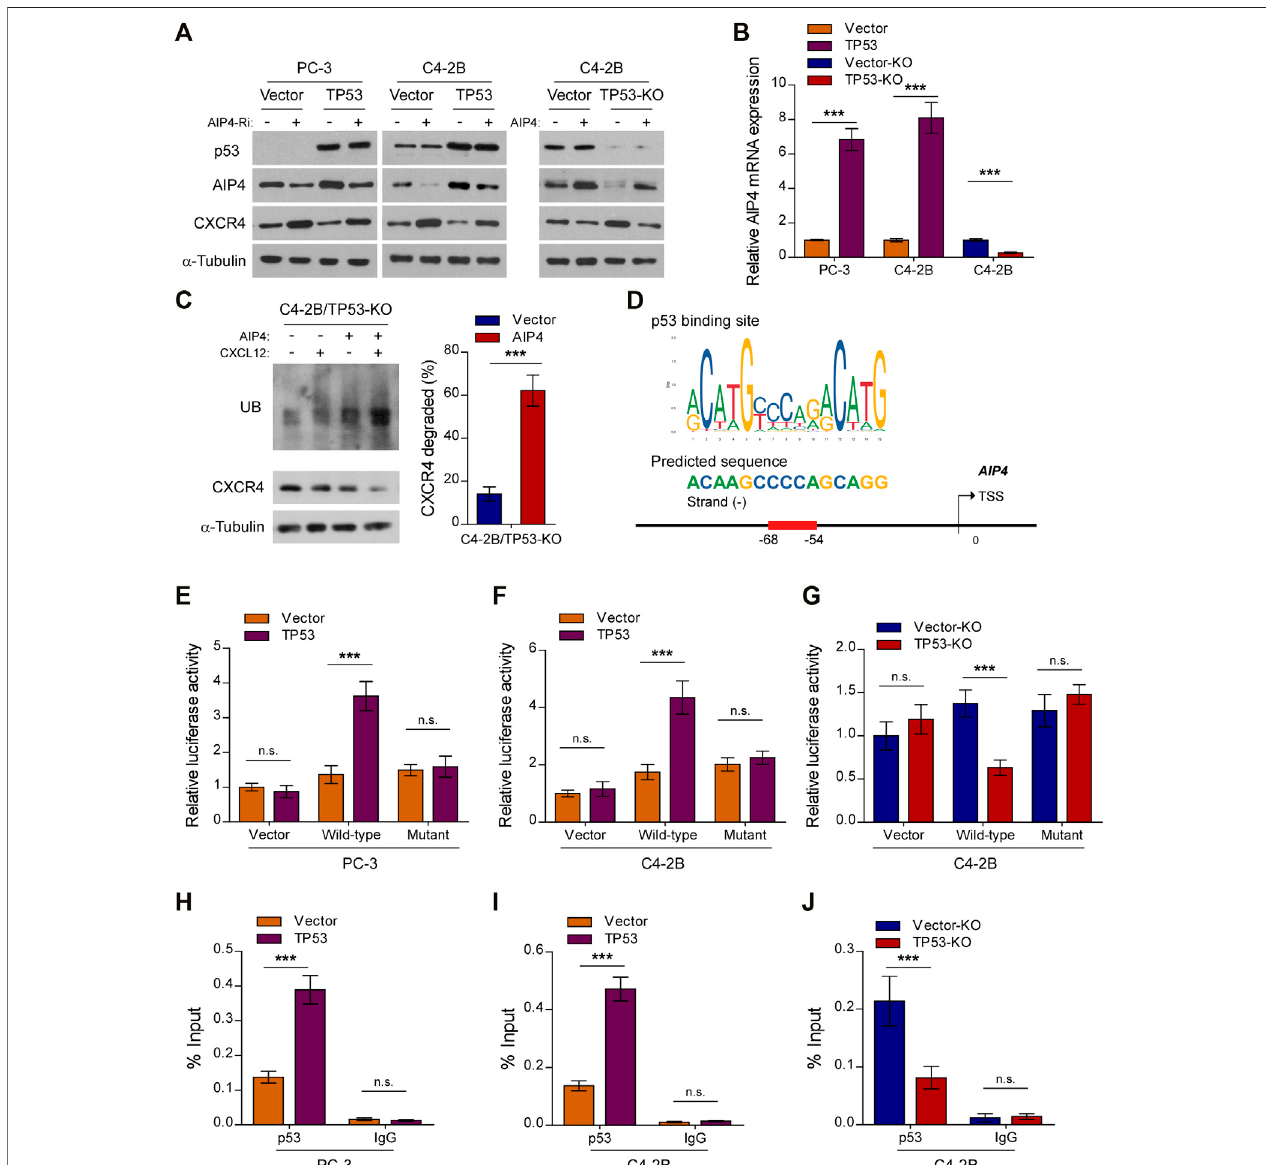
FIGURE 4 | Wt-p53 transcriptionally upregulates AIP4, a negatively regulator of CXCL12/CXCR4 signaling. (A) Western blot analysis of CXCR4 and AIP4 expressionintheindicatedcells. α -Tubulinservedasaloadingcontrol. (B) Real-timePCRanalysisof AIP4 mRNAexpressionintheindicatedcells.Transcriptlevelswere normalized to GAPDH. (C) Ubiquitination of CXCR4 was detected by Western blot. C4-2B/ TP53 -KO cells transfected with HA-tagged CXCR4 (1 µg) and 3 × FLAG- tagged ubiquitin (1 µg) plus either empty vector or AIP4 plasmid, were treated with or without CXCL12. Cell lysates were incubated with an anti-HA antibody and the immunoprecipitateswereanalyzed bySDS-PAGEfollowedbywesternblotusing ananti-FLAG antibody. Totalcell lysates werealsosubjectedtoimmunoblottingto detect the expression of CXCR4. α -Tubulin was used as loading controls. Right panel: quanti fi cation of relative CXCR4 degradation. (D) Schematic illustration of the predicted binding site for p53 in the indicated AIP4 promoter regions. (E – G) Quanti fi cation of luciferase activity of the AIP4 promoter reporter (with wild-type or mutant putative p53-binding sequences) in the indicated cells. (H – J) ChIP analysis of enrichment of p53 on the AIP4 gene promoter. IgG was used as a negative control. Error bar represents the mean ± SD of 3 independent experiments. * p < 0.05, ** p < 0.01, *** p < 0.001, n. s., no signi fi cance.